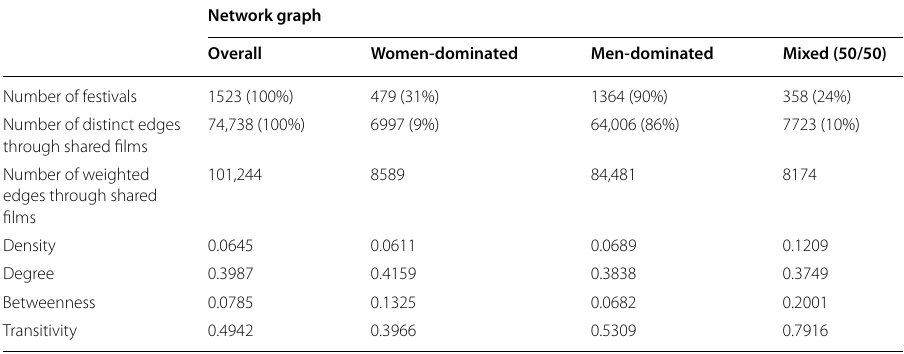
Table 7 Descriptive statistics and global network measures for all network graphs for second operationalization Network graph Overall Women-dominated Men-dominated Mixed (50/50) Number of